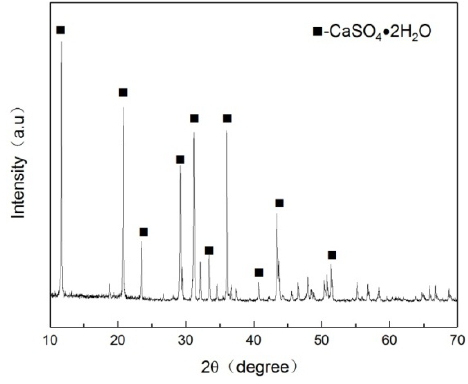
Figure 2. XRD patterns of FGD gypsum.